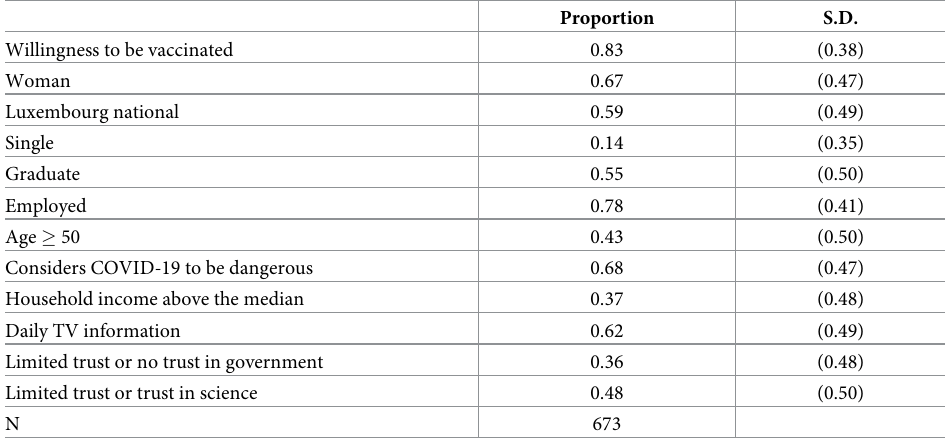
Table 1. Descriptive statistics of the surveyed